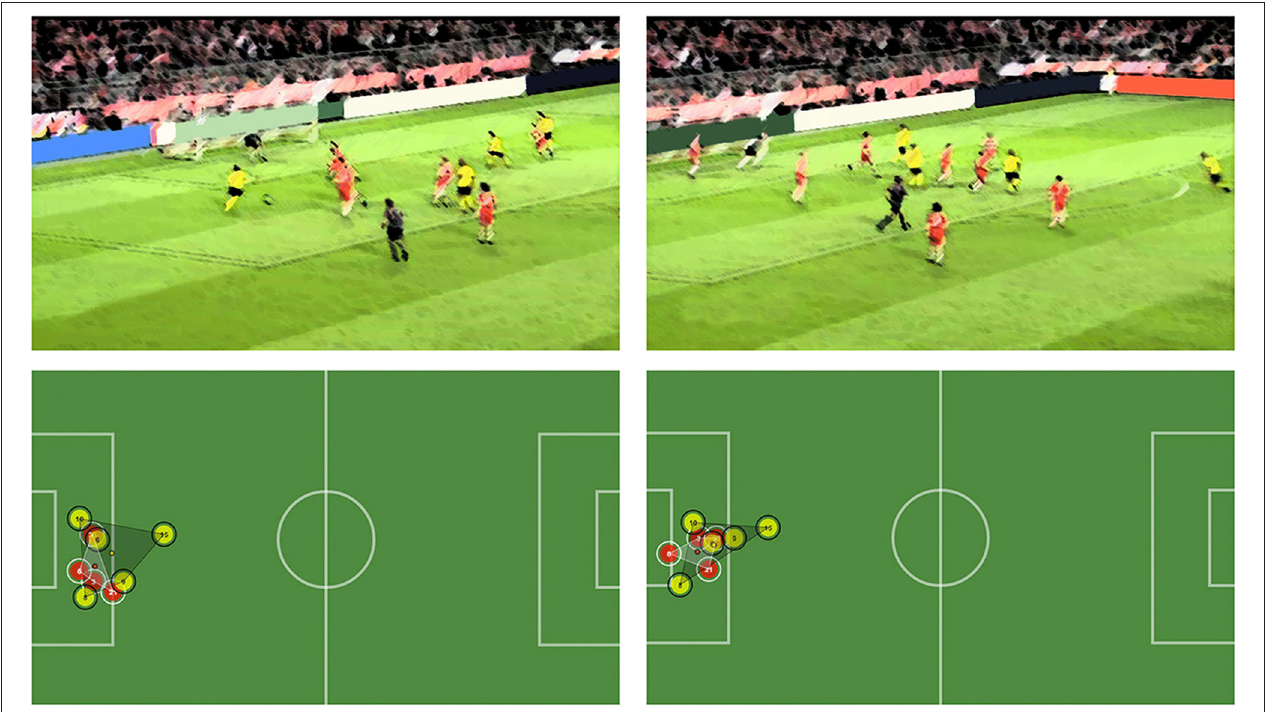
FIGURE 7 | First moment of low coordination between two defenders (Players 3 and 6, red). The outcome is a goal by the attacking team.